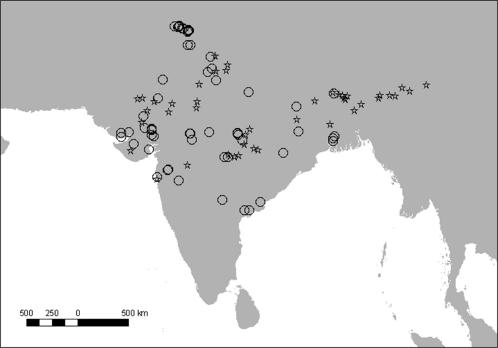
Locations of sites studied in India.Sites from which liver samples were obtained from carcasses of domesticated ungulates in 2004–2005 for diclofenac assays are shown by circles (n = 67) and centroids of 73 road transect surveys used to measure the population trend of the oriental white-backed vulture in 2000–2003 are shown by stars.